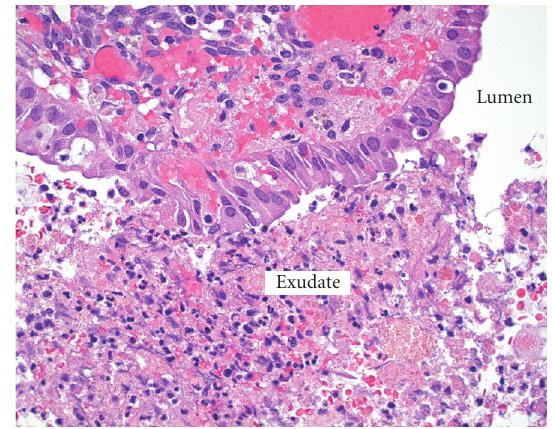
Figure 2: Endometrioma with associated edema, hemorrhage, acute inflammation, and marked eosinophilia (H & E,